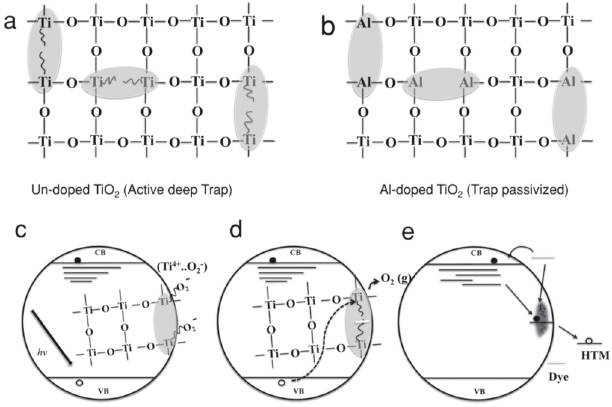
Figure 8. Al doped TiO 2 and the passivation of traps by Al. ( a ) Oxygen defect inducing deep electronic traps in TiO 2 . ( b ) Al substitution passivating oxygen traps. ( c ) Trap passivation produced by ionization of Ti. ( d ) Neutralized Ti by holes, which ( e ) enables charge recombination. Reprint with permission [102]; 2014, STM